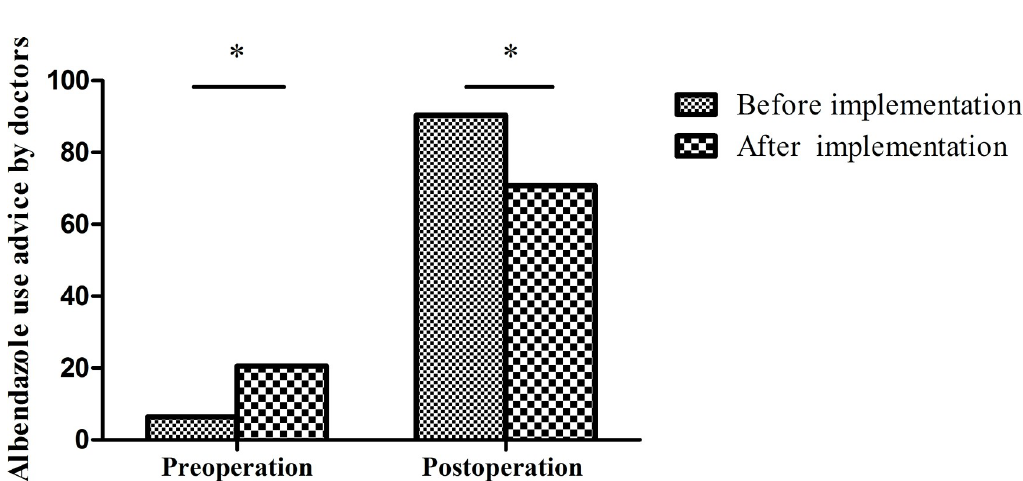
Fig 5. Albendazole use before and after program implementation. Before program implementation, preoperative use of albendazole was low. After program implementation, preoperative use of albendazole use increased from 6.4% to 20.5%. ( � p < 0.001 by the chi-square